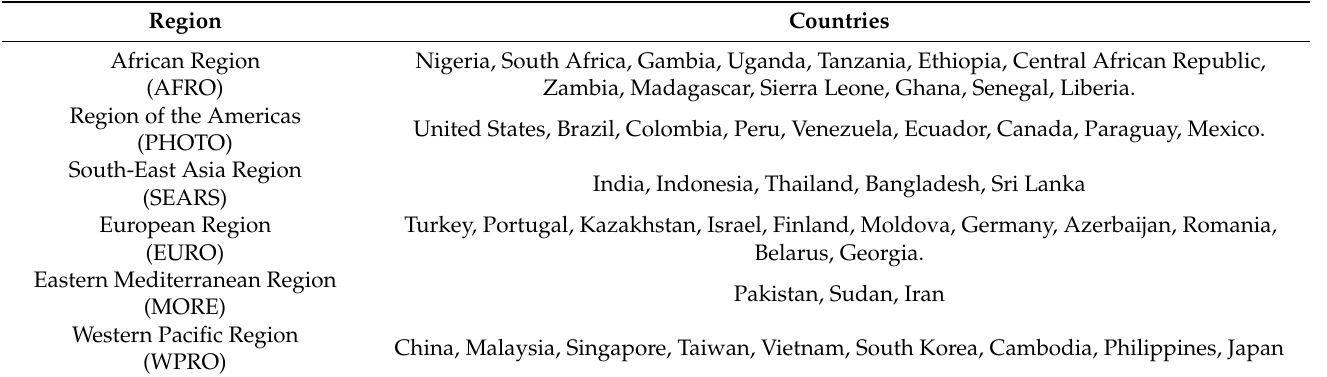
Table 6. Countries of WHO Regions that are included in all of the studied